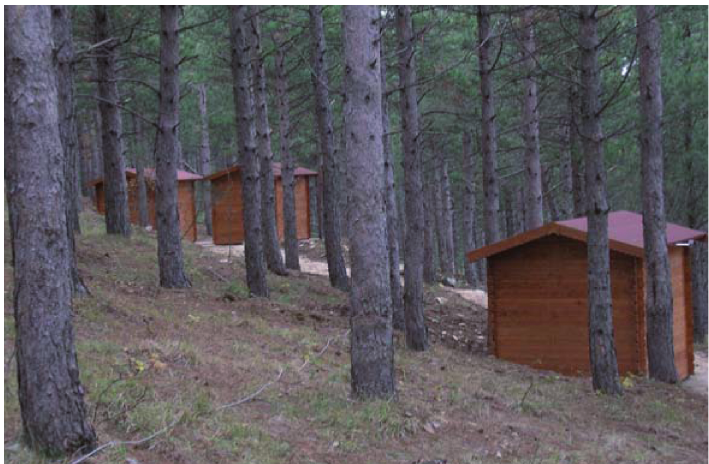
Fig. 3. A view of Duronia station.